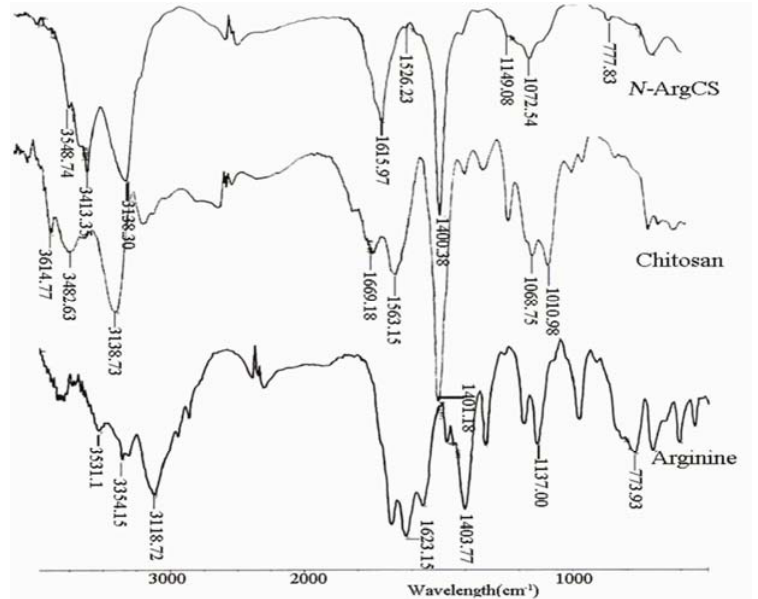
Figure 1. FTIR spectrums of the CS, L -Arg and N-